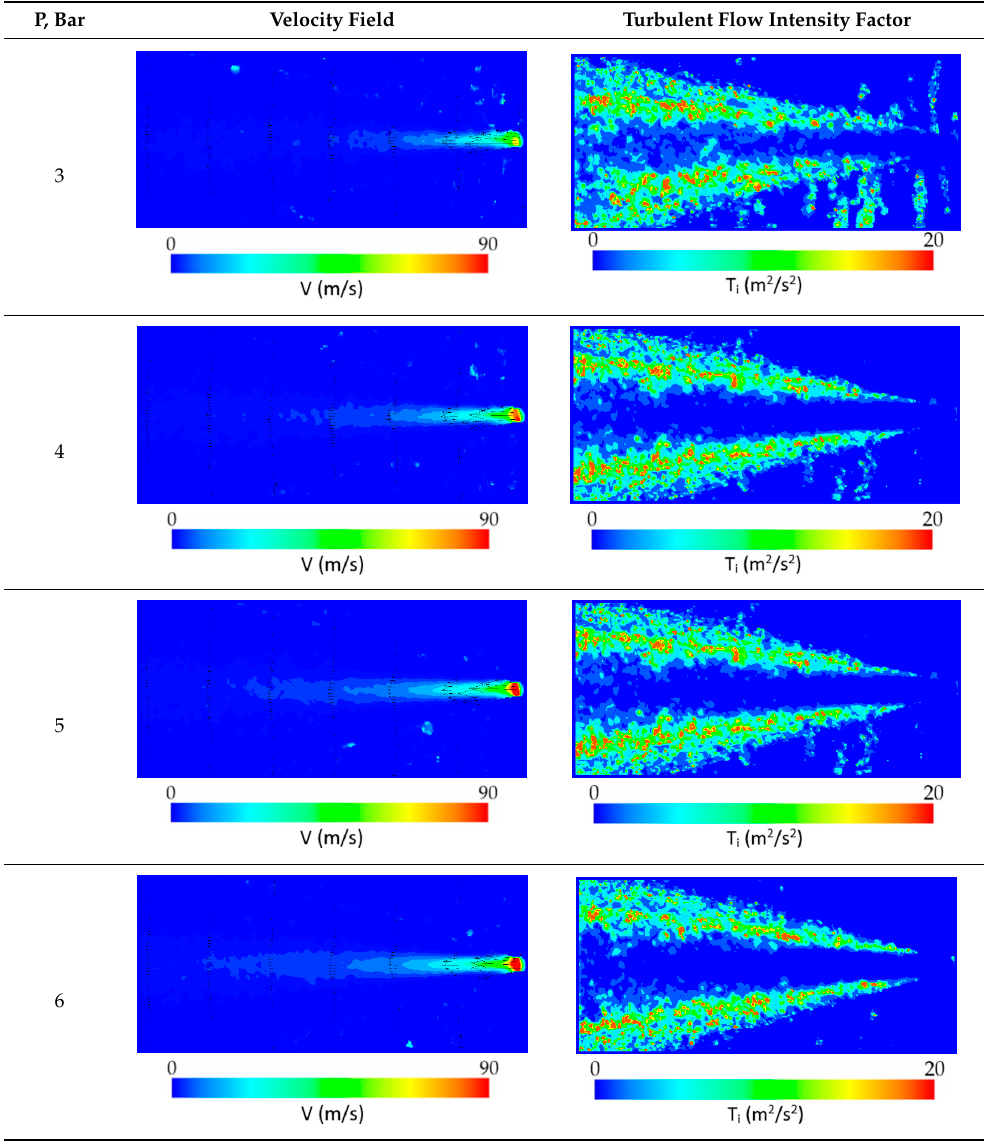
Table 5. Influence of pressure P supplying the nozzle on the character of velocity and turbulent flow intensity factor fields for stub regulation angle α = 45°.